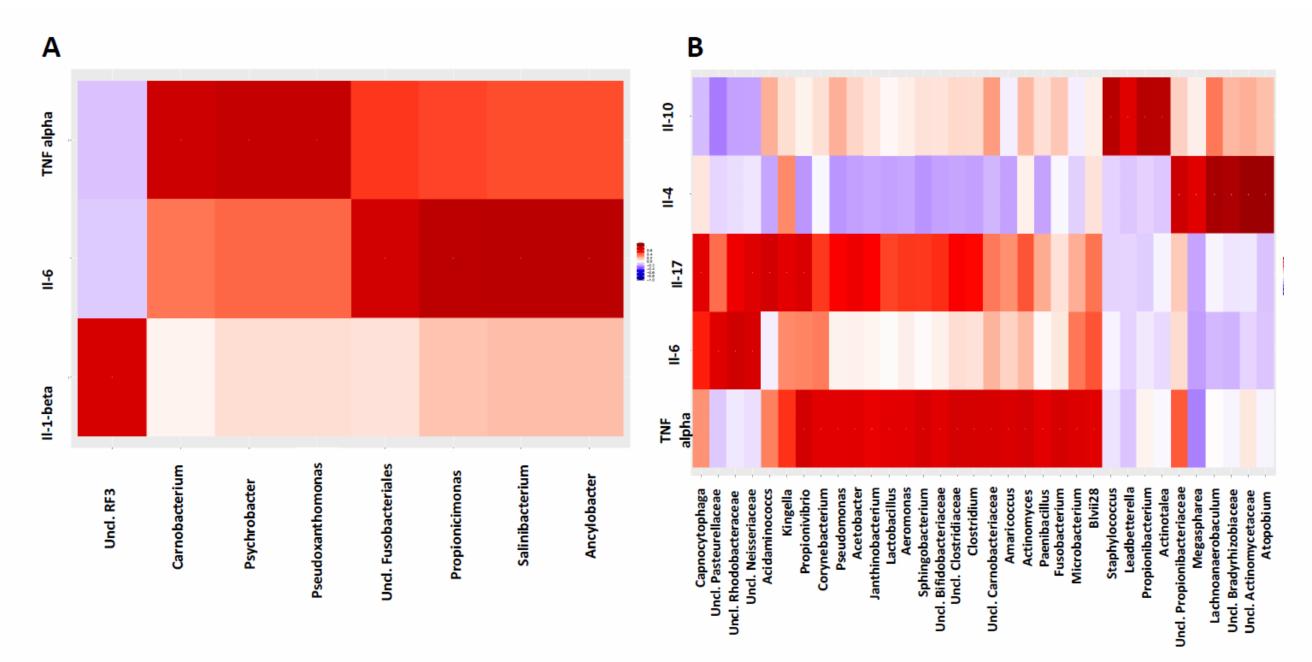
Figure 3. Correlation heatmaps for cytokines and oral microbiomes collapsed at genus level in the samples collected in ( A ) healthy sites and in ( B ) periodontitis sites. Increasing values are translated into colors from blue (negative correlation) to red (positive